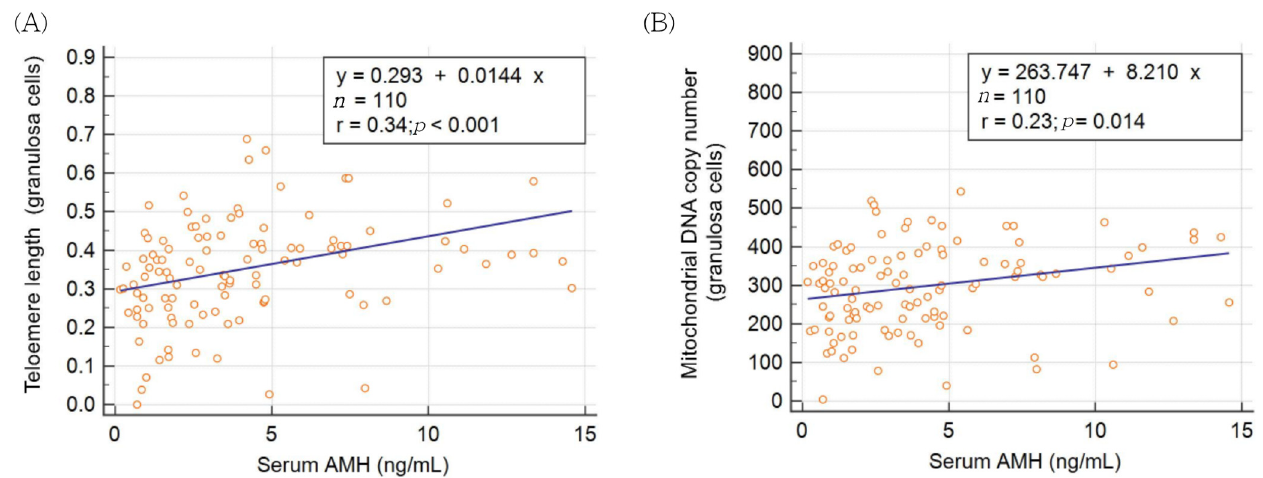
Figure 1. Correlation between serum anti-Mullerian hormone and ( A ) telomere length or ( B ) mito- chondrial DNA copy number in granulosa cells.